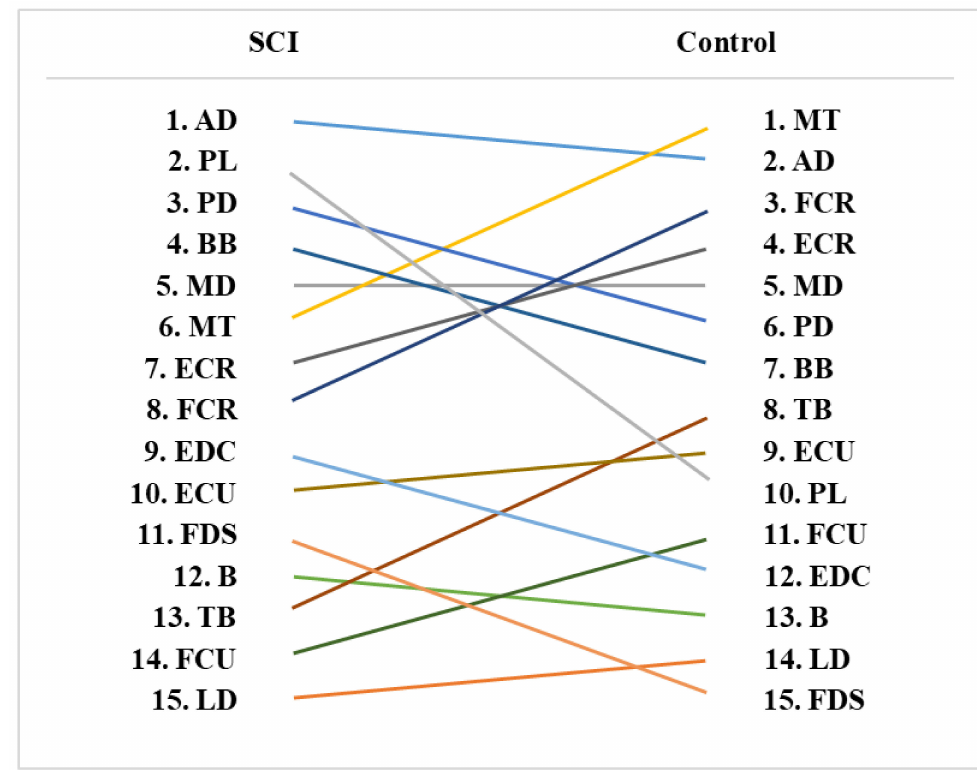
Figure 3. Muscle activity (peak value) rankings for the SCI and control